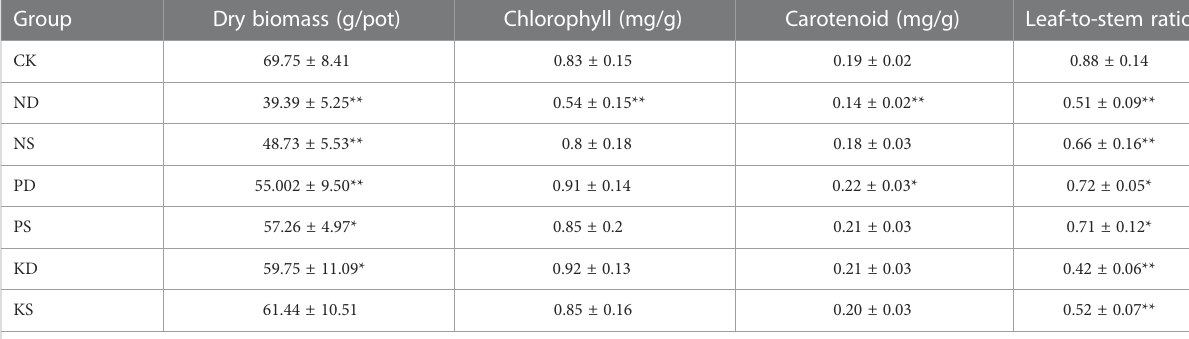
TABLE 2 Effect of different treatments on plant biomass, chlorophyll content, carotenoid content, and leaf-to-stem ratio.